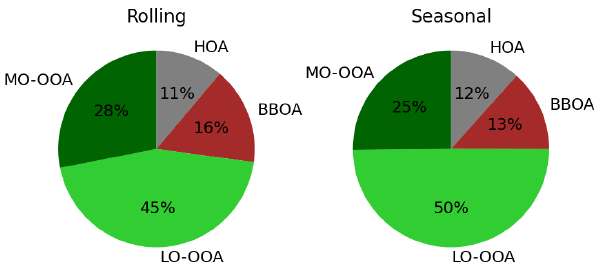
Figure 4. Pie charts of the mean concentrations of the main factors for the ensemble of all